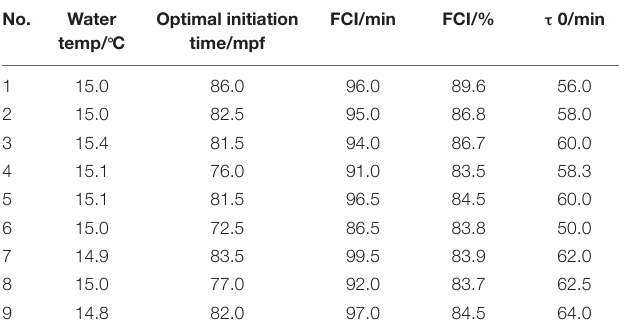
TABLE 2 | The optimal initiation time, FCI, and τ 0 in nine different tetraploid induction (4n)